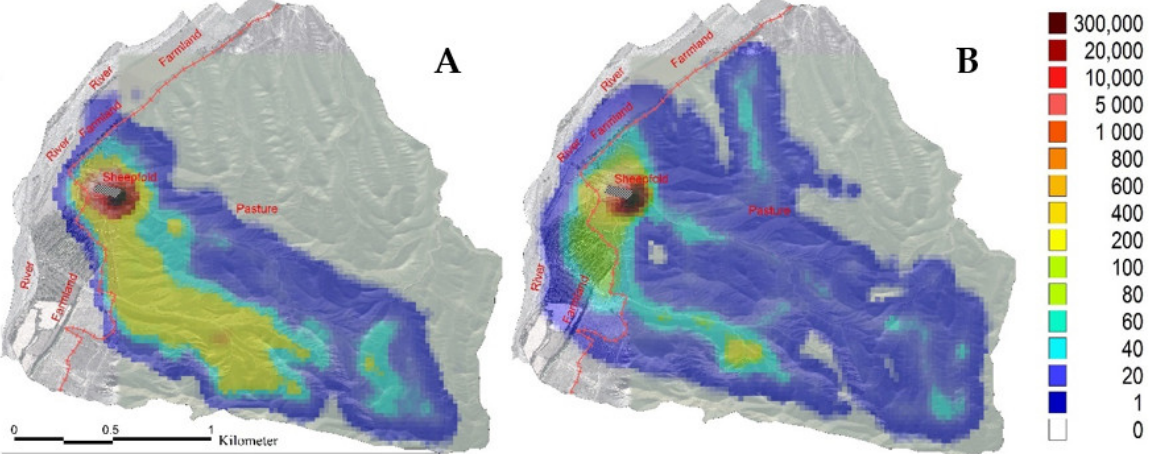
Figure 2. Distribution of the displacement track points of the grazing sheep in the spring ( A ) and autumn ( B ). autumn ( B ).